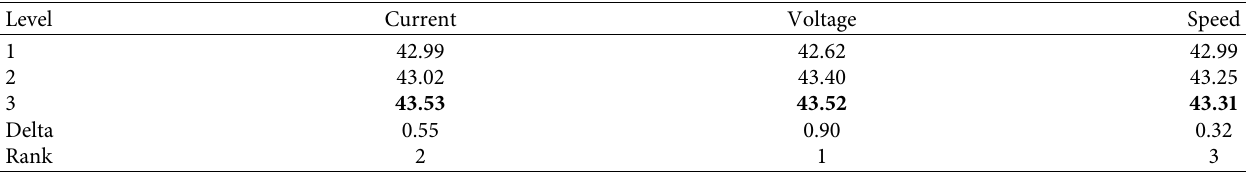
Table 10: Response table for signal-to-noise ratio of the hardness of HAZ.